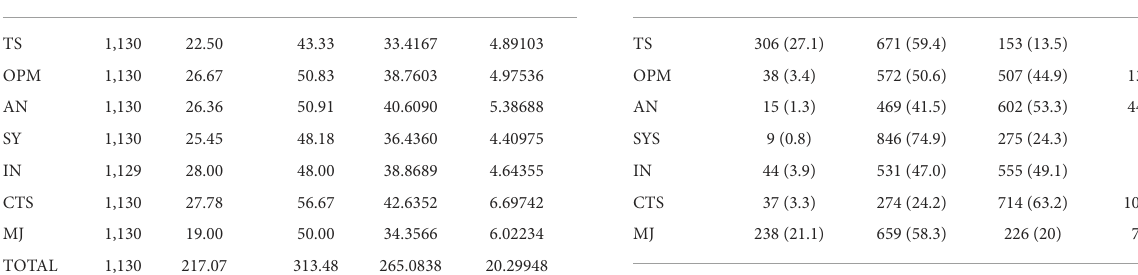
TABLE 1 Descriptive statistics regarding independent variables being studied.